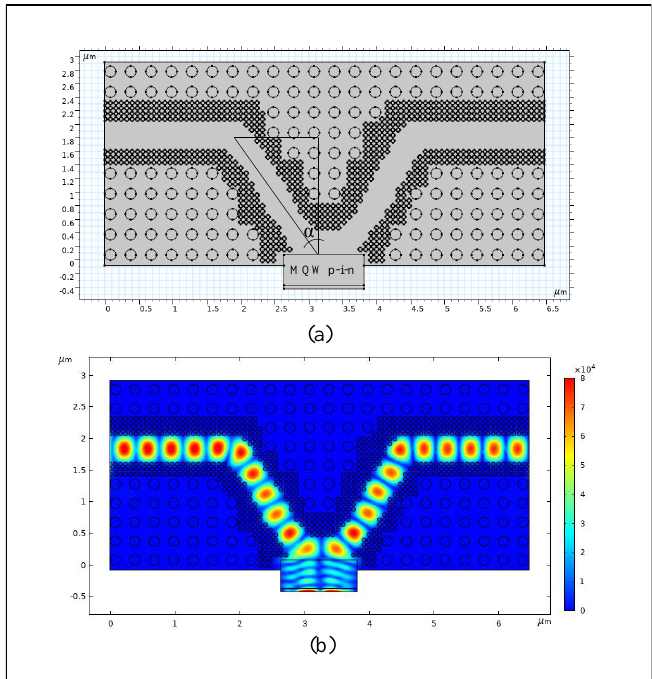
Figure 13. ( a ) The PhC structure elements to create a deflection angle of 37° at zero-volt bias (the modulator is on). ( b ) The electric field of TE polarization emitted in the PhCs waveguide corresponding to section